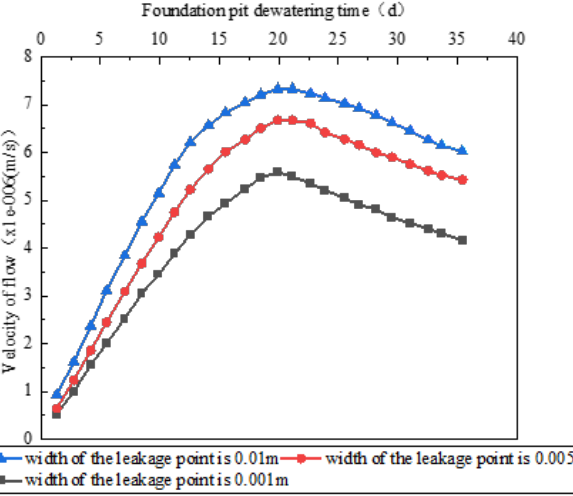
Figure 13. The curve of water velocity in leakage of different sizes with precipitation time.